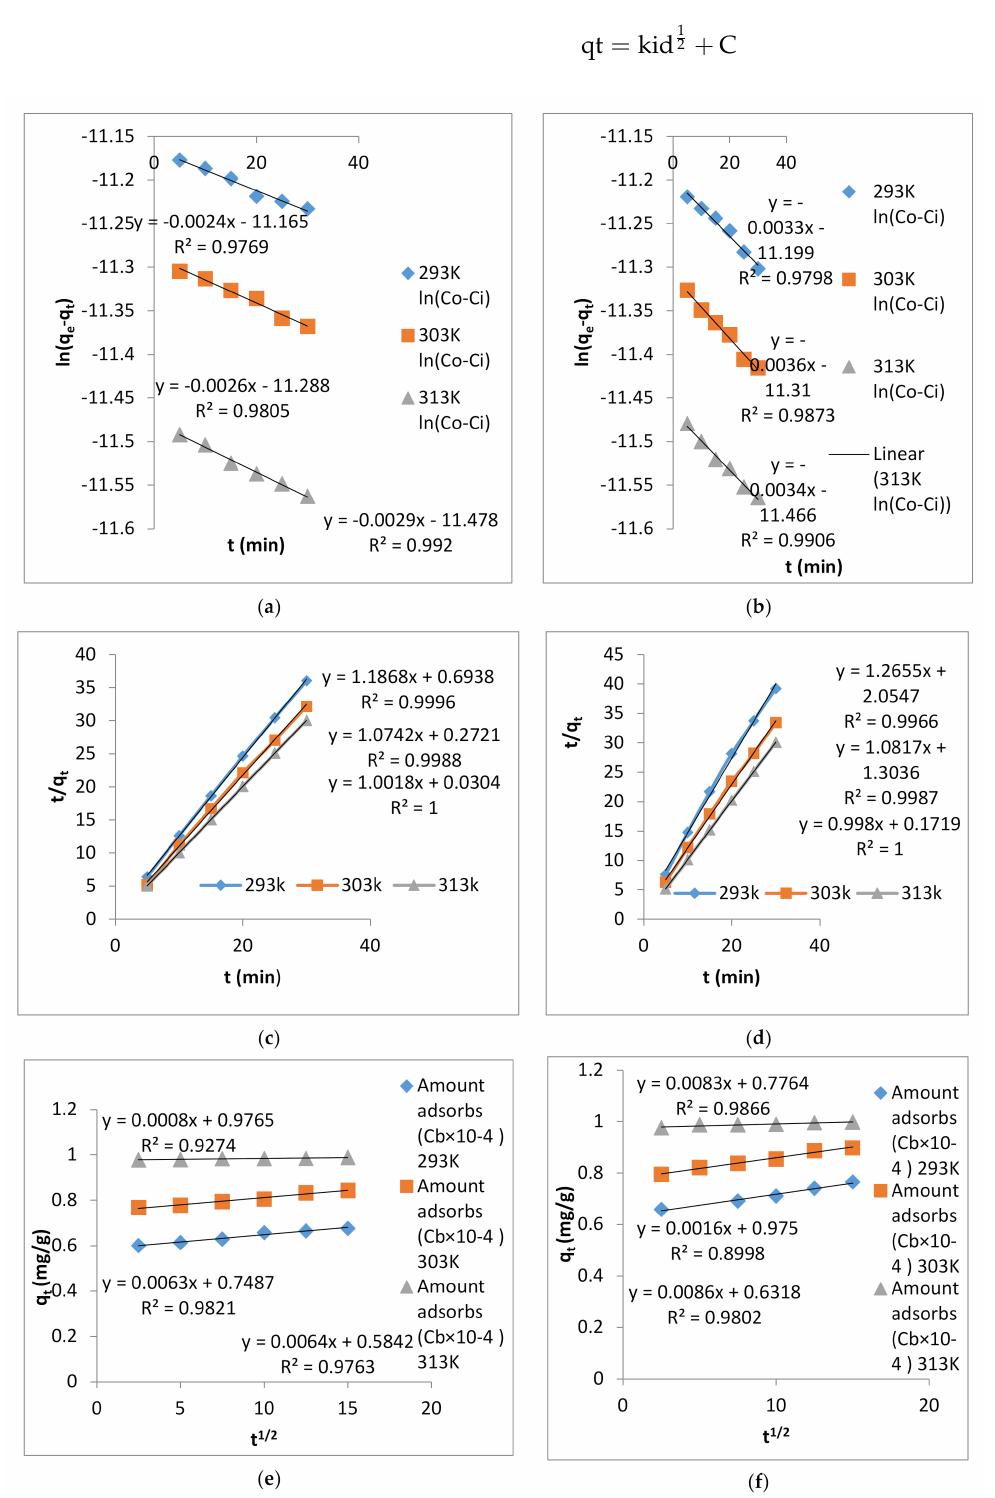
Figure 9. Kinetic models for RA4: ( a ) pseudo-first-order kinetics model; ( c ) pseudo-second-order kinetics model; ( e ) intraparticle diffusion model. For MB ( b ) pseudo-first-order kinetics model; ( d ) pseudo-second-order kinetics model; ( f ) intraparticle diffusion